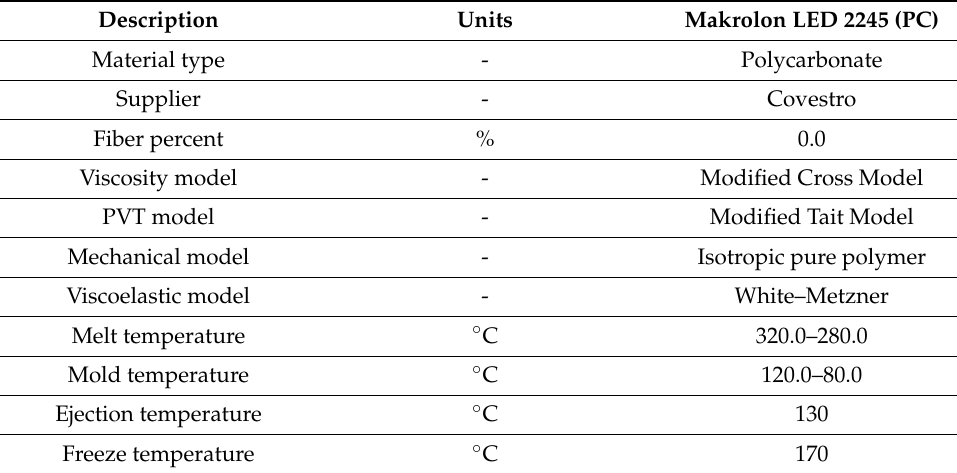
Table 6. Thermoplastic material definition for the numerical